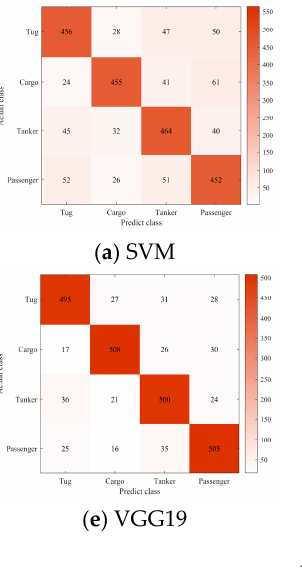
Figure 17. Confusion matrix of recognition results with the input of the MFCC by different methods.